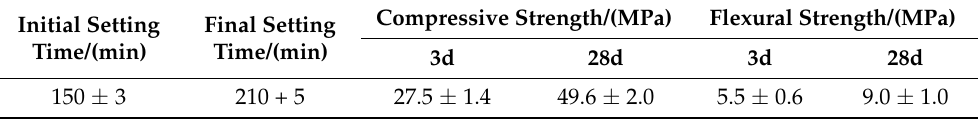
Table 1. Physical properties of the OPC.